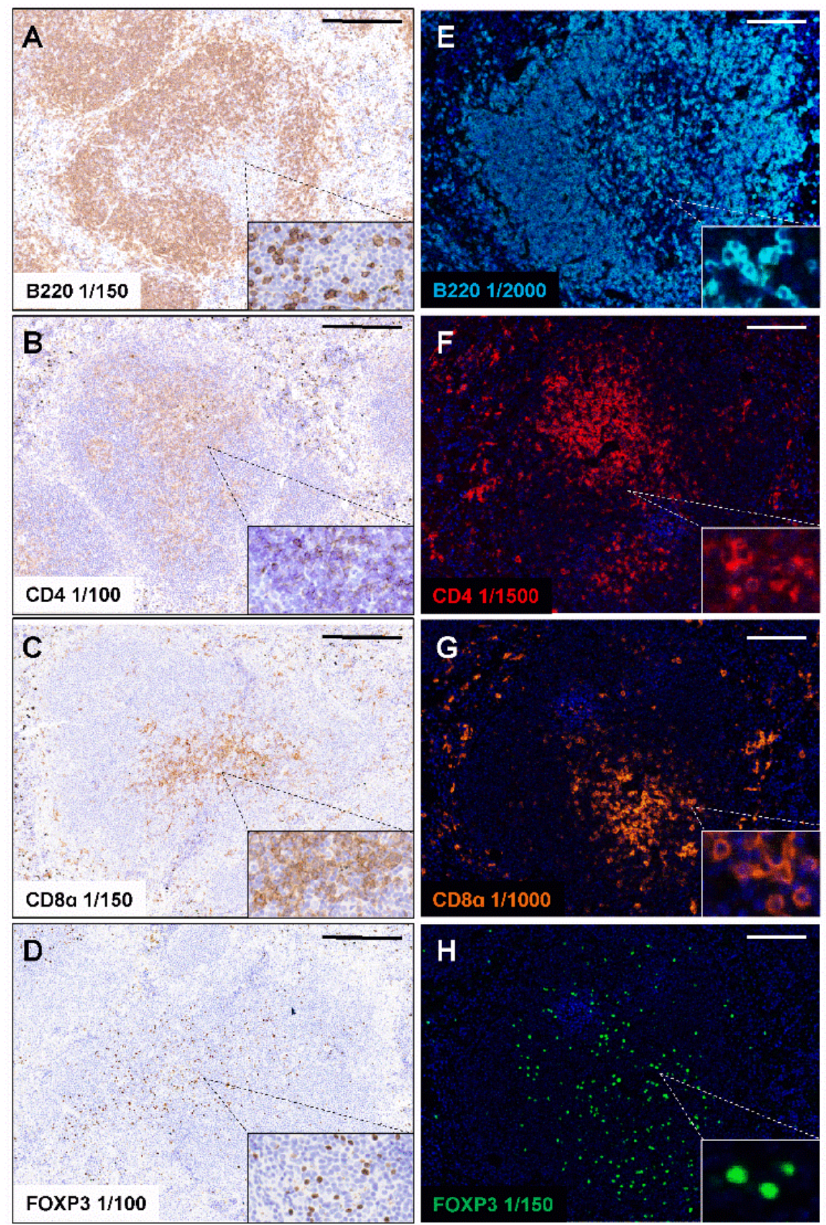
Figure 1. Standard chromogenic IHC and Opal monoplex staining of each immune marker on FFPE mouse spleens. Formalin-fixed paraffin-embedded (FFPE) C57BL/6 mouse spleens were stained with antibodies specific against B220 ( A ), CD4 ( B ), CD8 α ( C ) and FOXP3 ( D ) using standard chromogenic immunohistochemistry (IHC) and counterstained with haematoxylin. Scale bar: 200 µ m. Opal monoplex staining of B220 ( E ), CD4 ( F ), CD8 α ( G ) and FOXP3 ( H ) were performed on FFPE C57BL/6 mouse spleens and counterstained with DAPI. Tissue sections were imaged at 20 × magnification on Vectra 3. B220 (cyan); CD4 (red); CD8 α (orange); FOXP3 (green). Scale bar: 100 µ